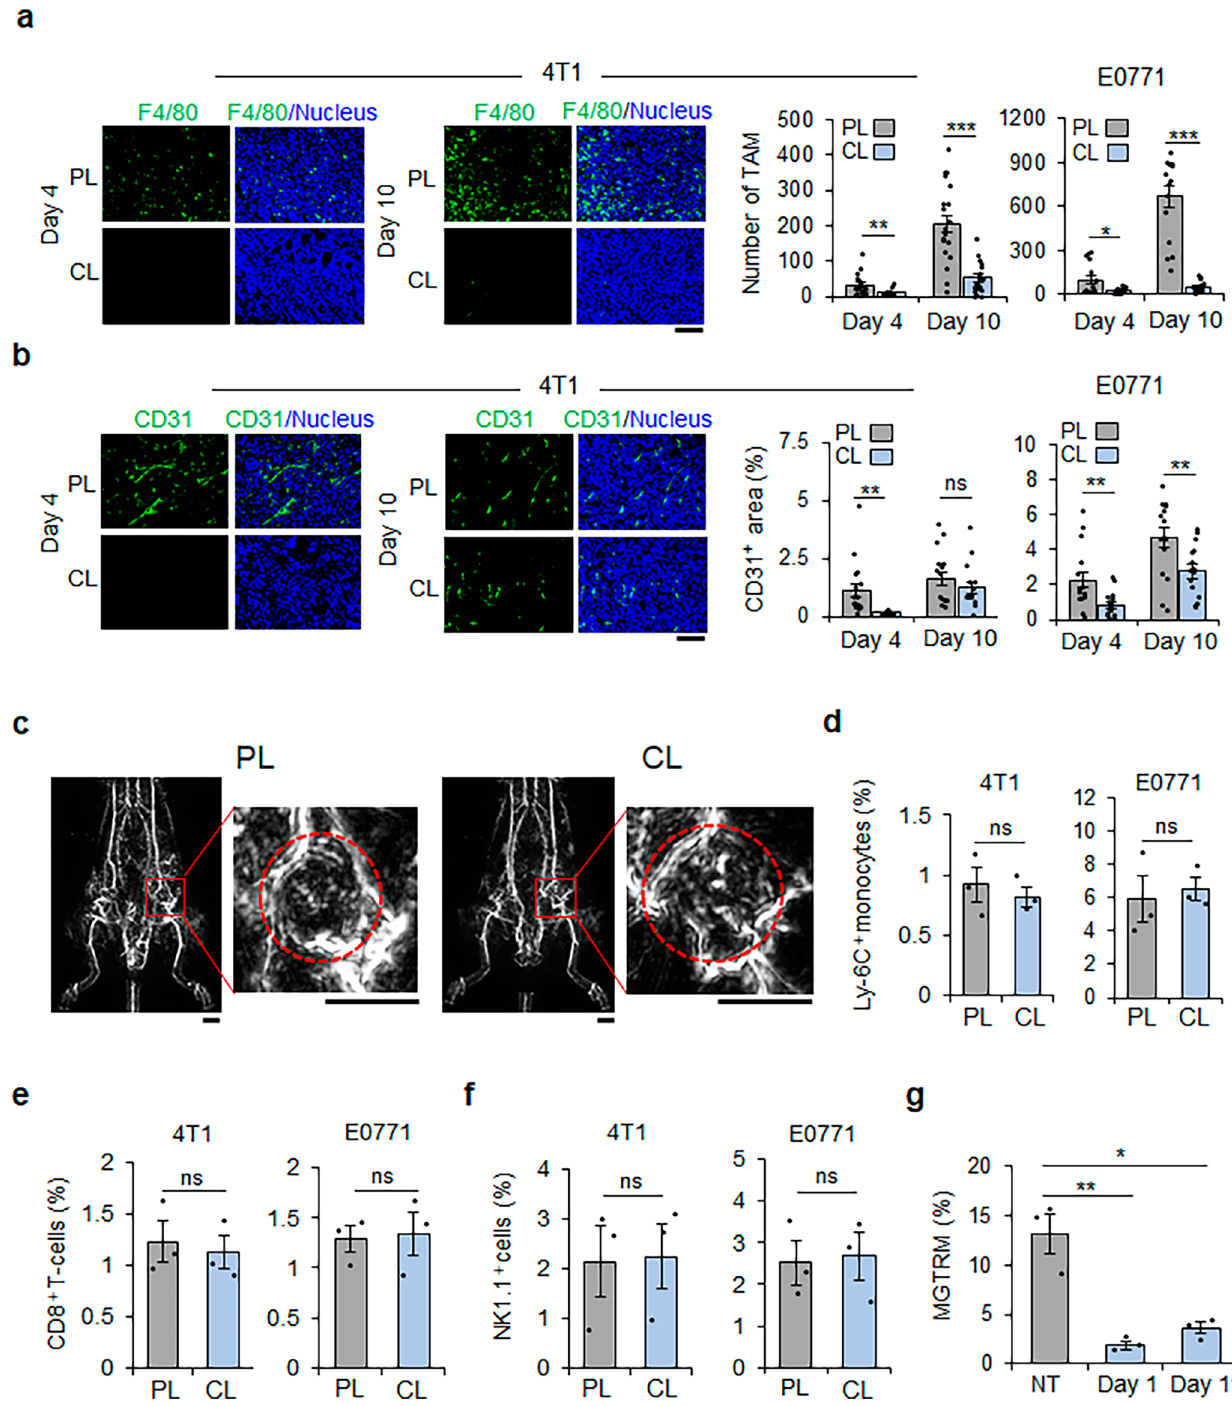
Fig. 4 MGTRMs are a major resource of tumor-associated macrophages (TAMs) and contribute to TNBC angiogenesis. a Representative fl uorescence images of 4T1 tumor (left) and average number of F4/80 + cells in a fi eld (right) in TNBC 4 and 10 days after transplantation. 4T1: n = 20, E0771: n = 15, * p < 0.05, ** p < 0.01, *** p < 0.001 ( t -test). Scale bar = 100 µ m. b Representative fl uorescence images of 4T1 tumor (left) and average % of the CD31 + area (right) in TNBC 4 and 10 days after transplantation. n = 15. ns, not signi fi cant, ** p < 0.01 ( t -test). Scale bar = 100 µ m. c Photoacoustic images of blood vessels in mice 10 days after 4T1 cell transplantation in PL- and CL-treated MGFPs. The tumor areas indicated by red squares are enlarged in the right-hand panels. The red dotted circle indicates the tumor area. Scale bar = 5 mm. d – f Percentage of CD11b + Ly-6C + monocytes, CD8 + T cells, and NK1.1 + cells among all tissue cells of TNBC 10 days after transplantation in PL- and CL-treated MGFP. n = 3. ns, not signi fi cant ( t -test). g Flow cytometry analysis of CD11b + F4/80 + MGTRMs in tumor-free BALB/c MGFP 1 and 11 days after CL administration. n = 3. * p < 0.05, ** p < 0.01 ( t -test). a , b , d – g Error bars indicate s.e.m.